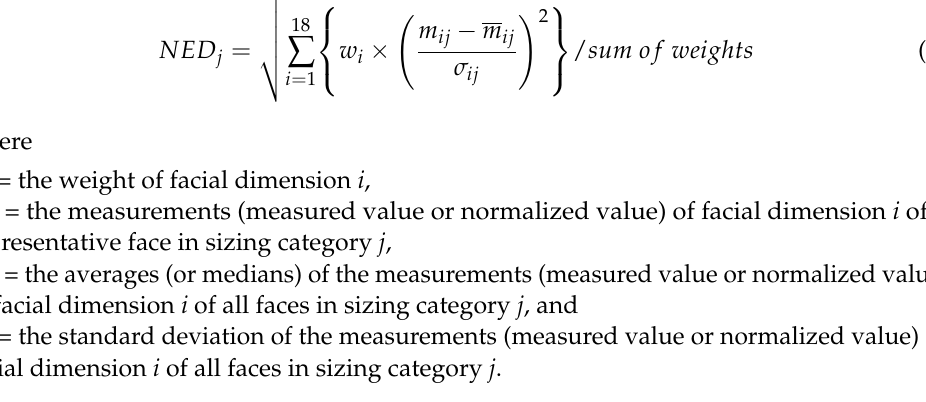
Table 4. Normalized Euclidean distance (NED) of the identified representative face by the weighted sum of Euclidean distance (WSED) calculation method (unit: mm; pilot identification numbers are indicated in